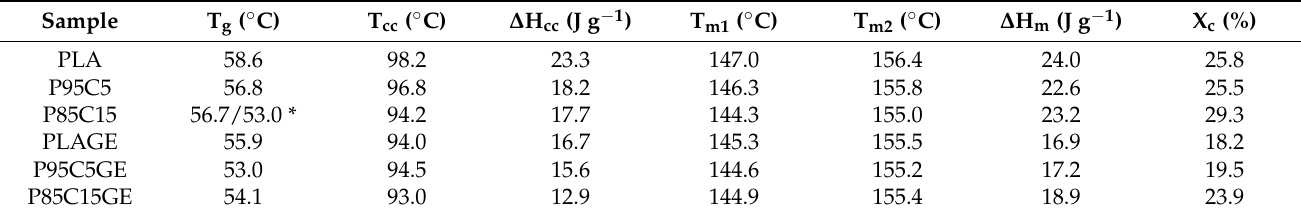
Table 1. Thermal properties of neat PLA and the blends obtained by